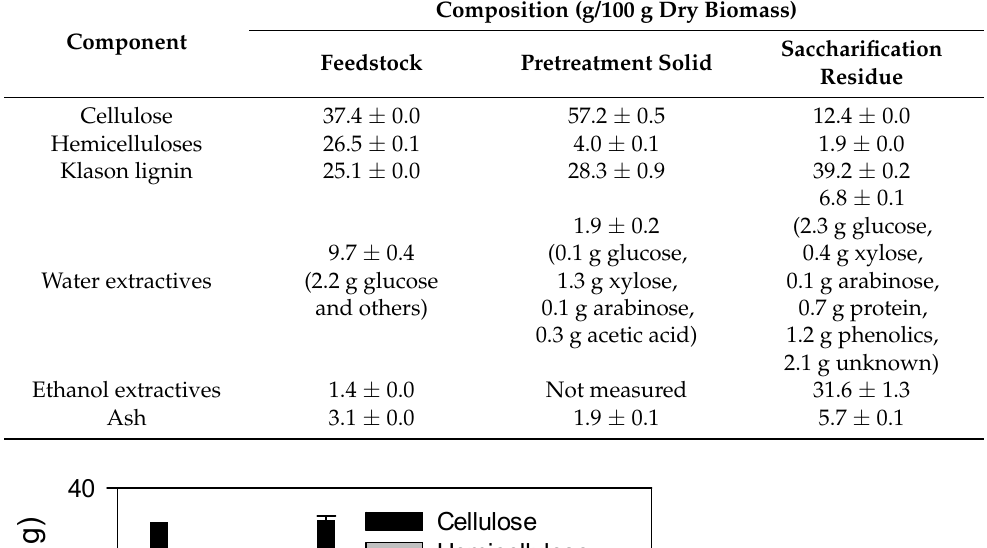
Table 1. Composition of Miscanthus feedstock, pretreatment solid, and saccharification residue.